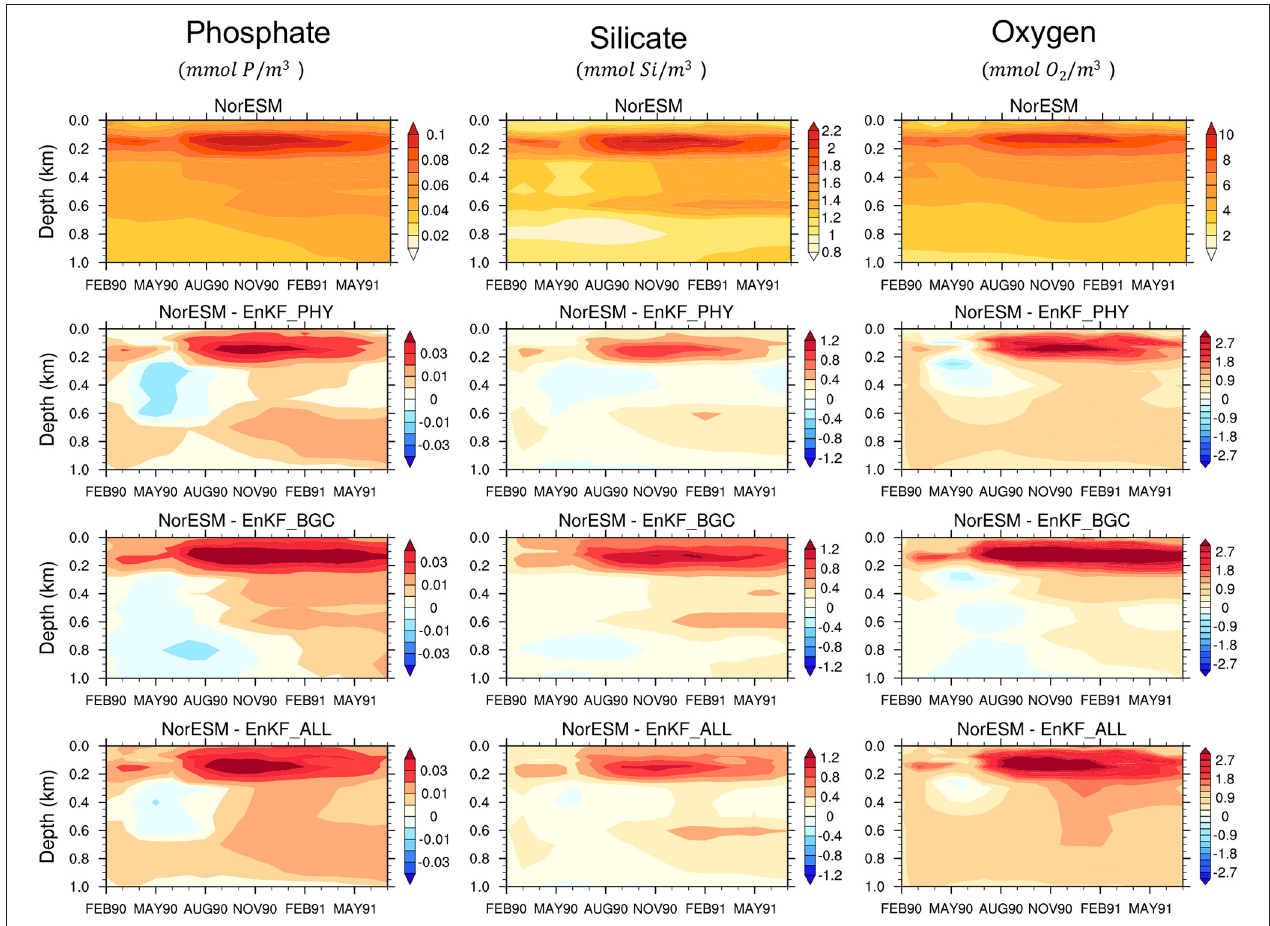
FIGURE 3 | Same as Figure 2 but for Phosphate (first column), Silicate (second column), and Oxygen (third